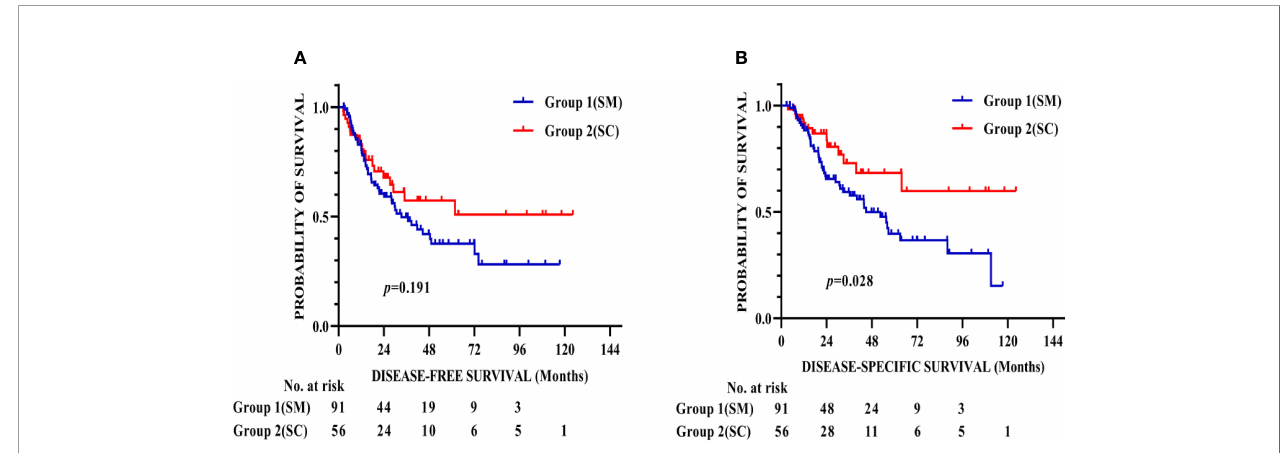
FIGURE 2 | Kaplan – Meier survival curves for DFS (A) and DSS (B) of 147 patients after propensity score matching. The patients in Group 2 (SC) had better DSS than that in Group 1 (SM) ( p = 0.028). DFS, Disease-free survival; DSS, Disease-speci fi c survival.